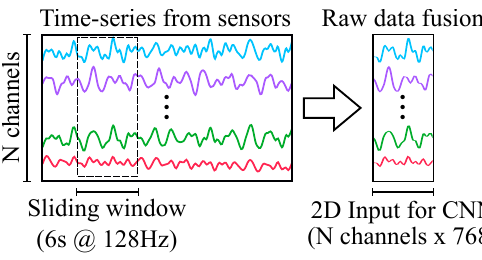
Figure 4. Raw data fusion scheme. The data from different sensors’ channels is segmented using a sliding window and concatenated as a 2D input for the